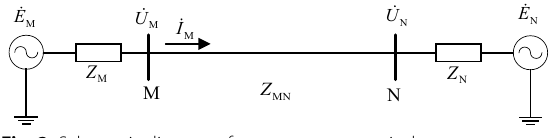
Fig. 2 Schematic diagram of two-generator equivalence system